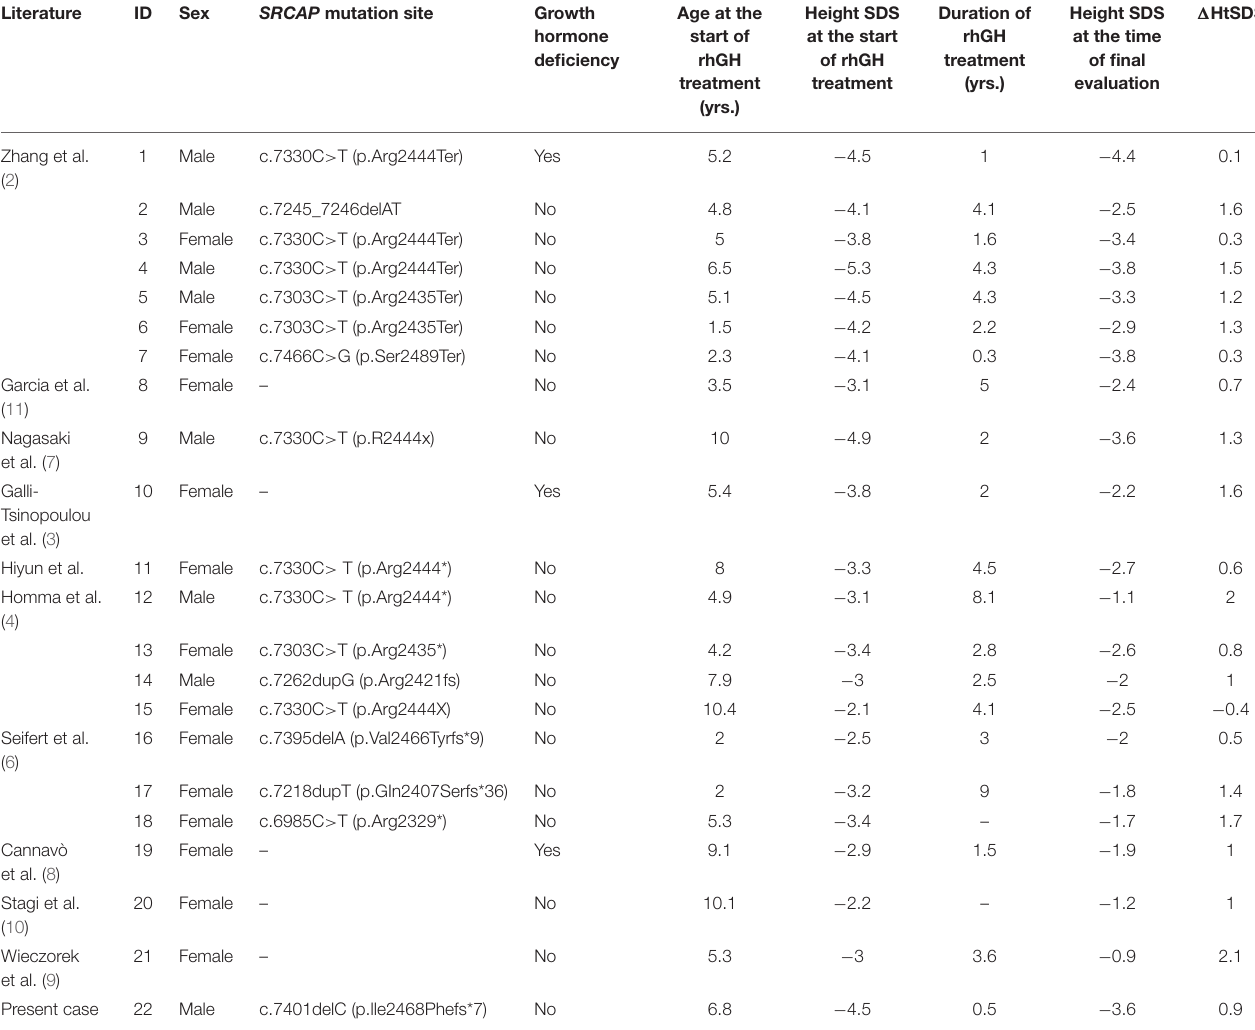
TABLE 2 | Basic information of 22 patients with FHS treated with rhGH. Literature SRCAP mutation site Growth